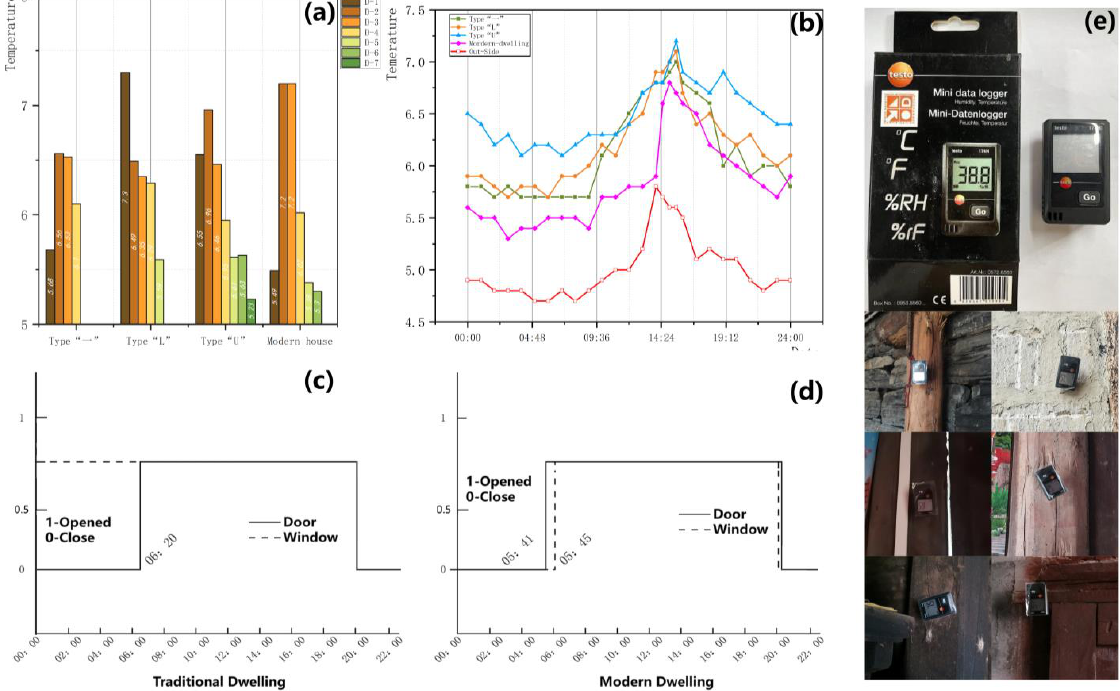
Figure 4. Indoor temperature and the schedule of window and door. ( a ) Average temperature at measurement point; ( b ) Temperature fluctuations at the measuring point; ( c ) Schedule of traditional residential window and door; ( d ) Schedule of modern residential window and door; and ( e ) Testing instruments and hanging points.